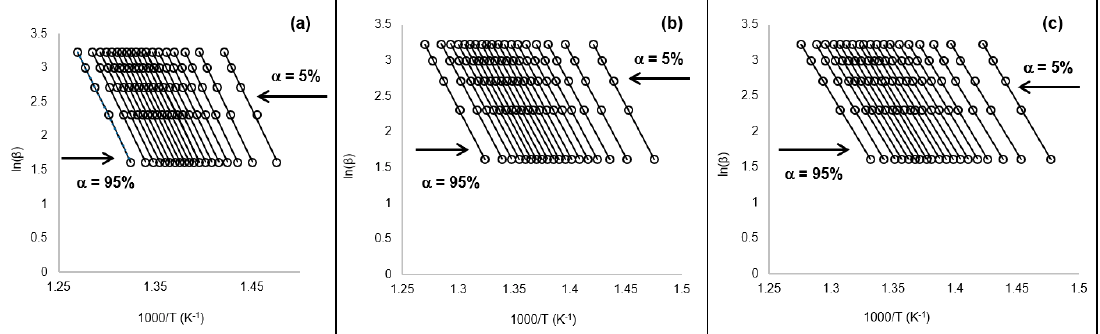
Figure 5. OFW method determination plot for apparent activation energy ( E a ) showing ( a ) 50/50, ( b ) 25/75, and ( c ) 0/100 unexposed samples. Note: conversions in sequential order from right (5%) to left (95%) with 5% intervals.